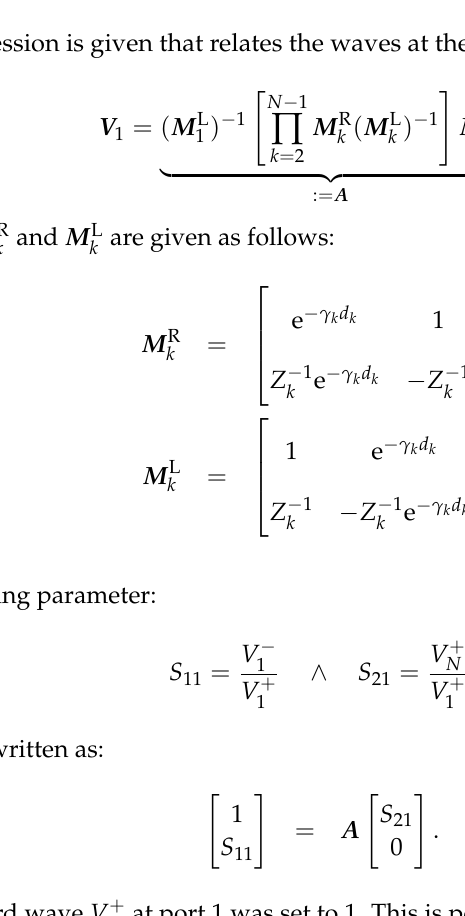
Figure 2. Schematic representation of the layered transmission